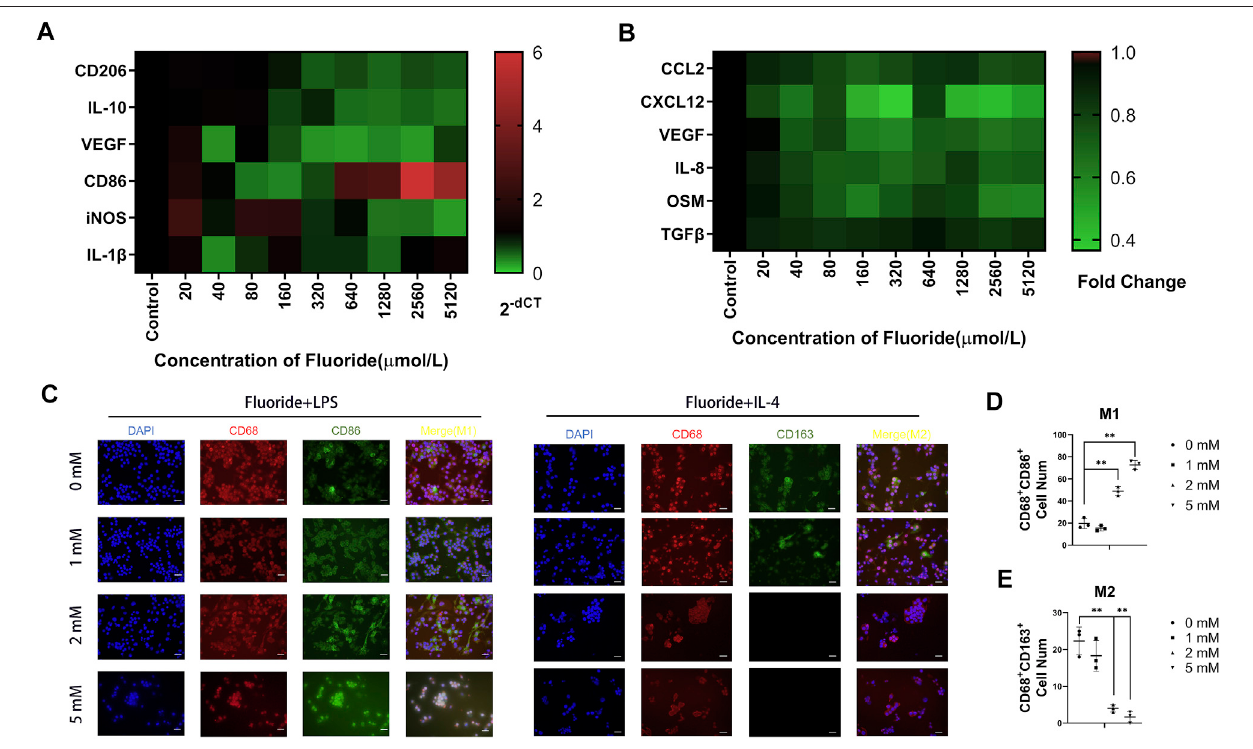
FIGURE 4 | Fluoride suppressed macrophage polarization in vitro. (A) RT-qPCR assay was performed to determine the expression of the M1-relative gene, includingCD86,IL-1 β ,andiNOS.Meanwhile,theM2-relativegeneCD206,IL-10,andTGF- β weredetected. (B) Quanti fi cationofCCL2,CXCL12,OSM,IL-8,VEGF,and TGF- β proteinlevelsonthemediumsupernatantof fl uoride-treatedRAWbyELISA.Datawerecollectedat24 hafter fl uoridetreatment. (C) Immuno fl uorescencestaining wasusedtodeterminethe fl uoride-treatedRAW,includingCD86(green)andCD206(green),CD68(red),andDAPI(blue)(magni fi cationofupimages=×400,scale bar = 50 μ m). (D,E) Immuno fl uorescence staining quanti fi ed analysis. Optical density by ImageJ. * p < 0.05, ** p < 0.01, t -test. Each experiment was carried out in